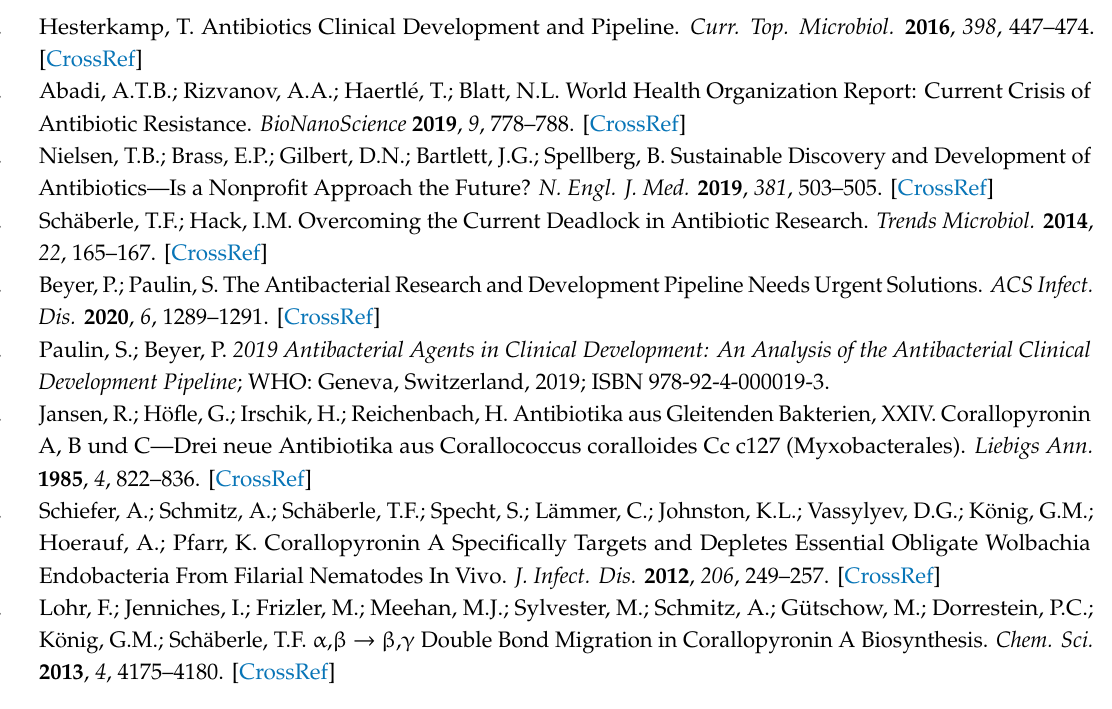
Figure A1. Chemical structure of corallopyronin C (CorC).